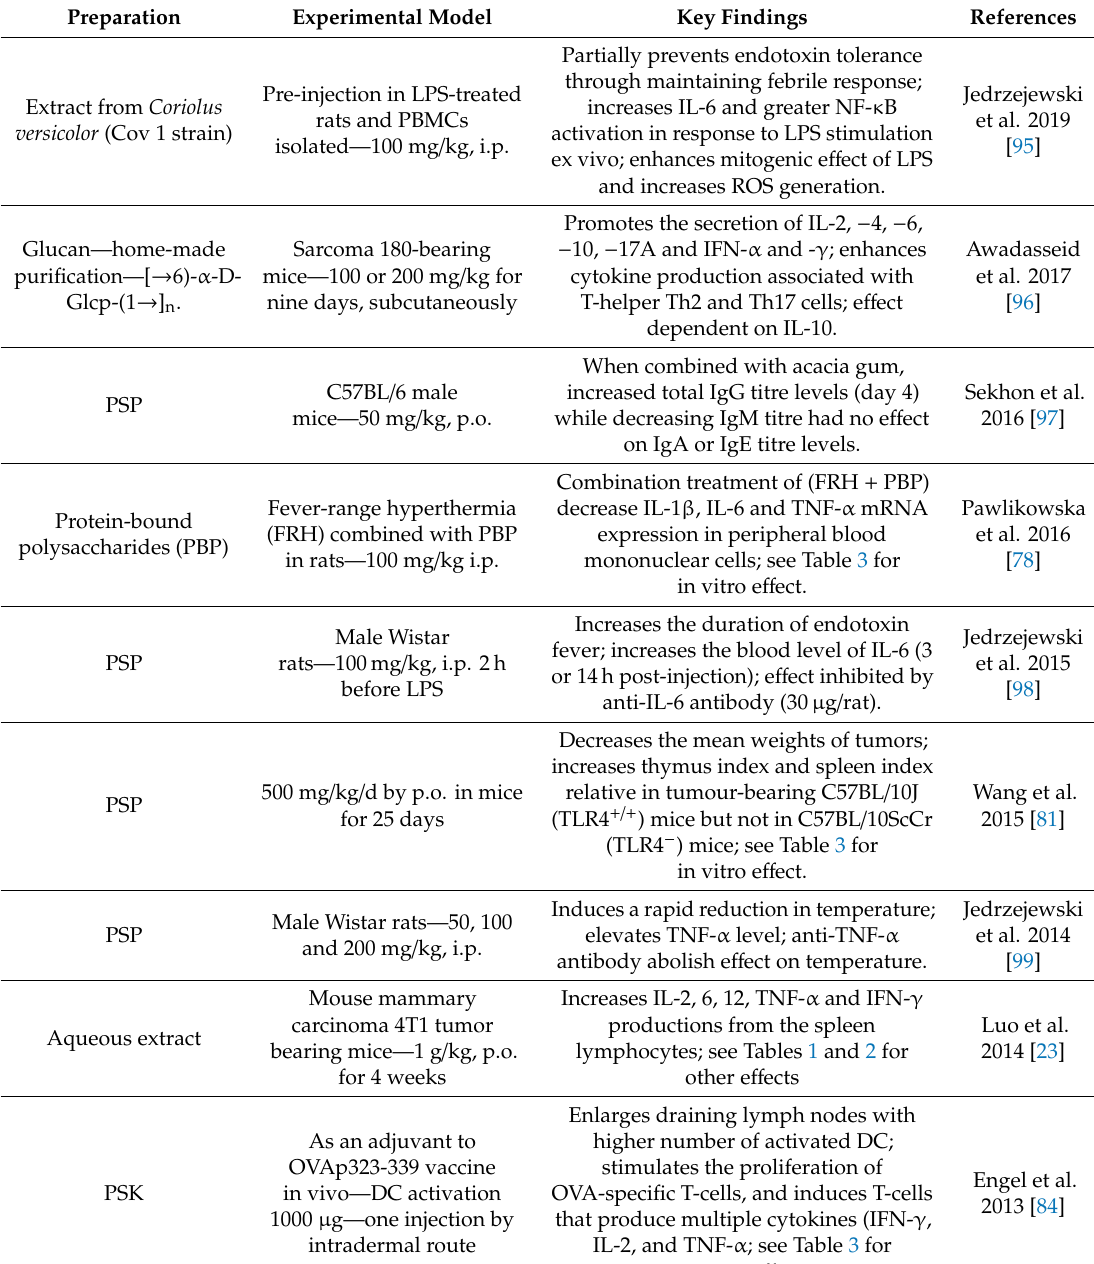
Table 4. Immunomodulatory e ff ects related to cancer: in vivo